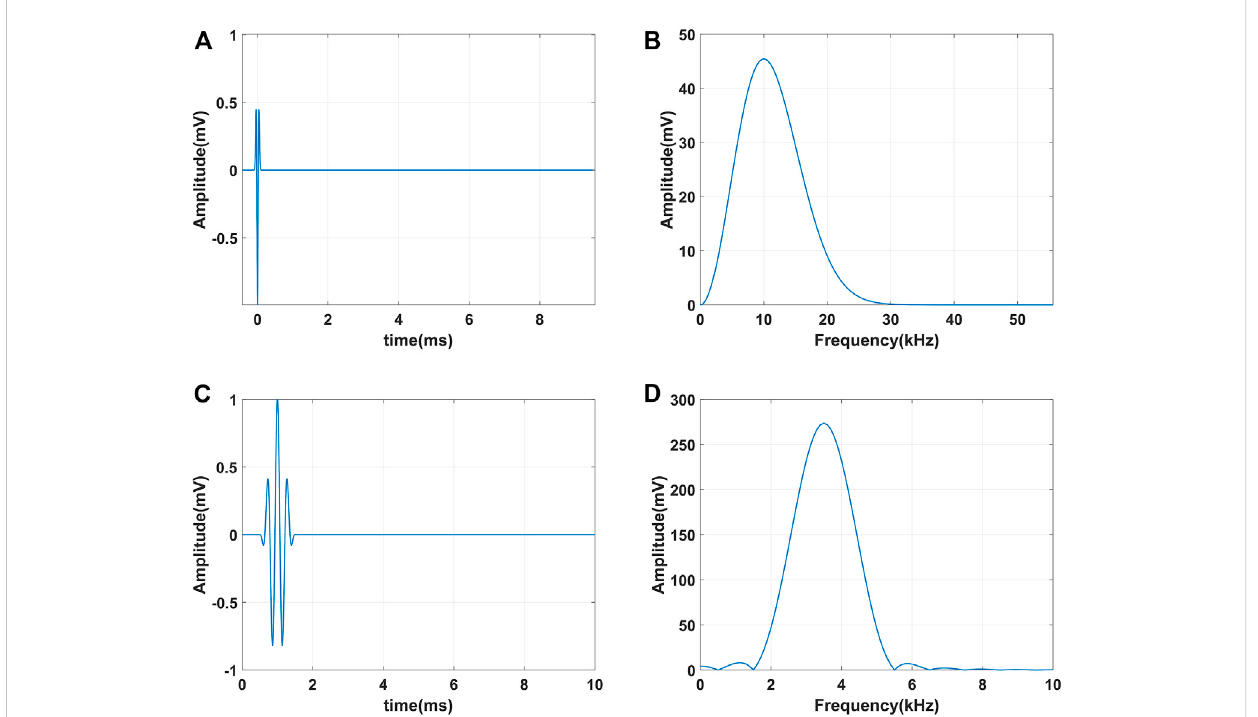
FIGURE 2 Sound source waveform and amplitude spectrum. (A, B) are the waveform and amplitude spectrum of the Ricker wavelet source that excites the monople P wave, respectively; (C, D) are the waveform and amplitude spectrum of the narrow-band cosine envelope source that excites the dipole S wave, respectively.